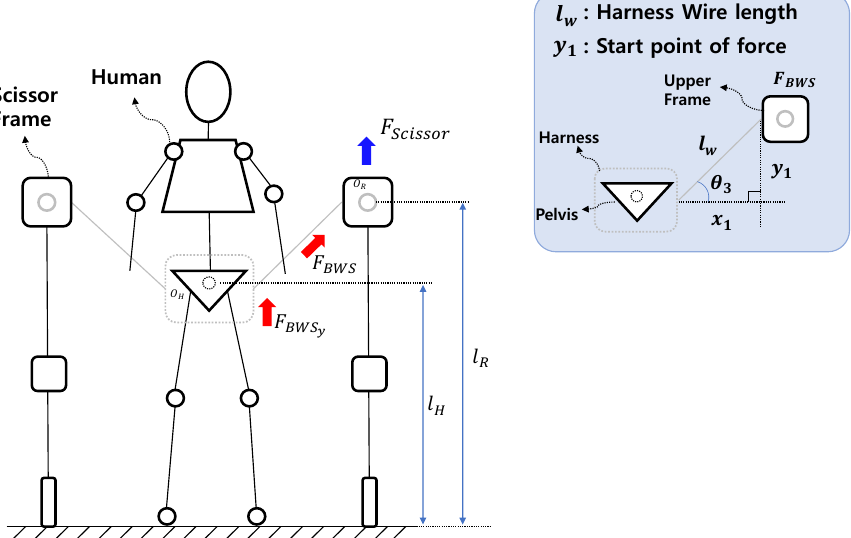
Figure 3. The scissor mechanism applies the BWS function for paralyzed patients. The direction of force action is